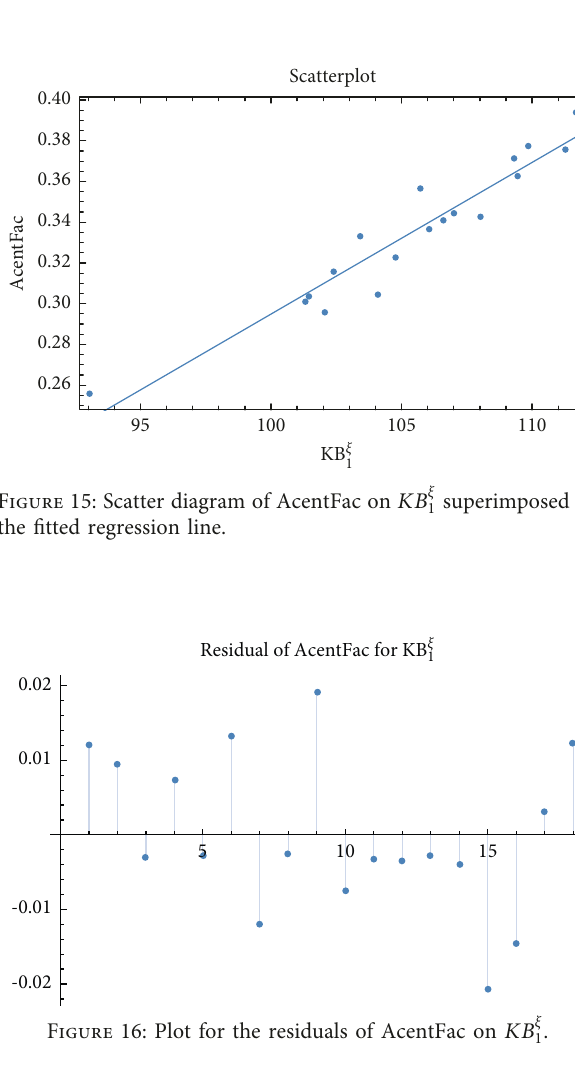
superimposed by ξ